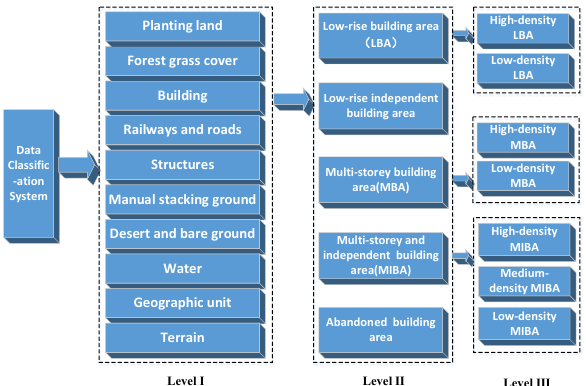
Figure 1. Geographical National Conditions Monitoring Data classification system (only including all Level Ⅰ classes, Level Ⅱ building classes and Level Ⅲ building